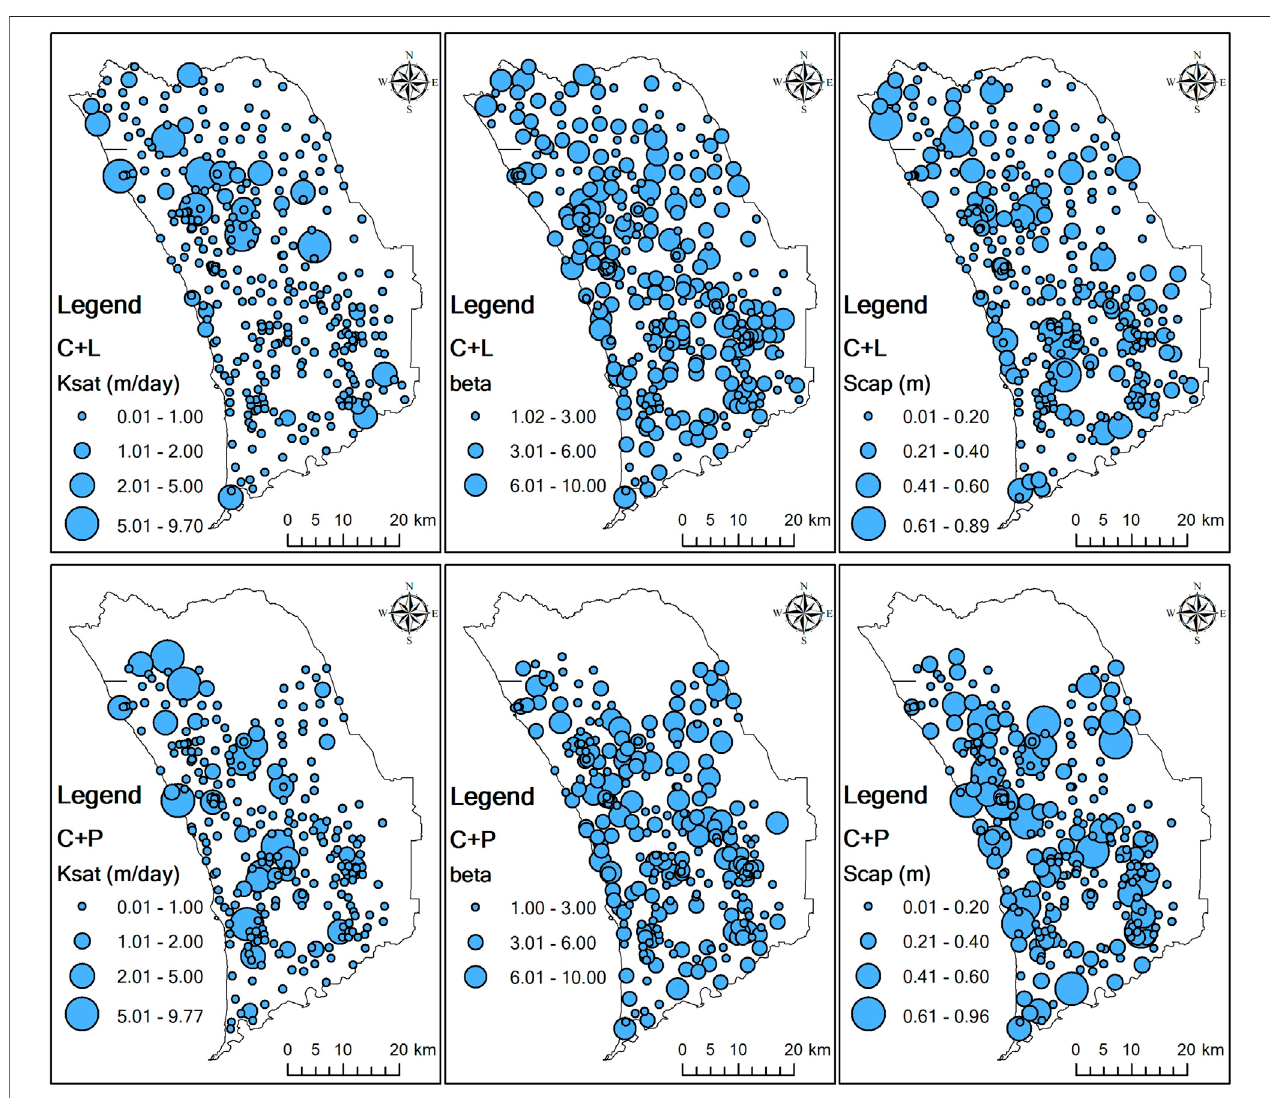
FIGURE 13 | Spatial distribution of the calibrated parameters of the